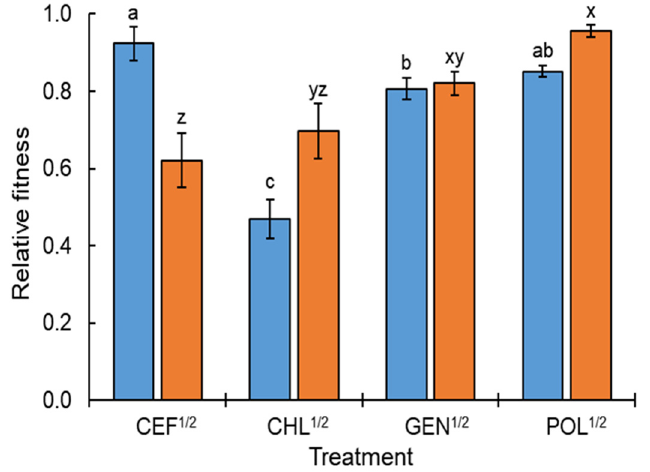
Figure 4. Relative fitness of Salmonella Typhimurium ATCC 19585 (ST ATCC ; ■ ) and S . Typhimurium CCARM 8009 (ST CCARM ; ■ ) exposed to a half minimum inhibitory concentration (MIC) of cefotaxime (CEF 1/2 ), chloramphenicol (CHL 1/2 ), gentamicin (GEN 1/2 ), and polymyxin B (POL 1/2 ). Different letters (a–c) on the bars show significant differences among treatments within persistence at p < 0.05, and different letters (x–z) on the bars show significant differences among treatments within resistance at p < 0.05.